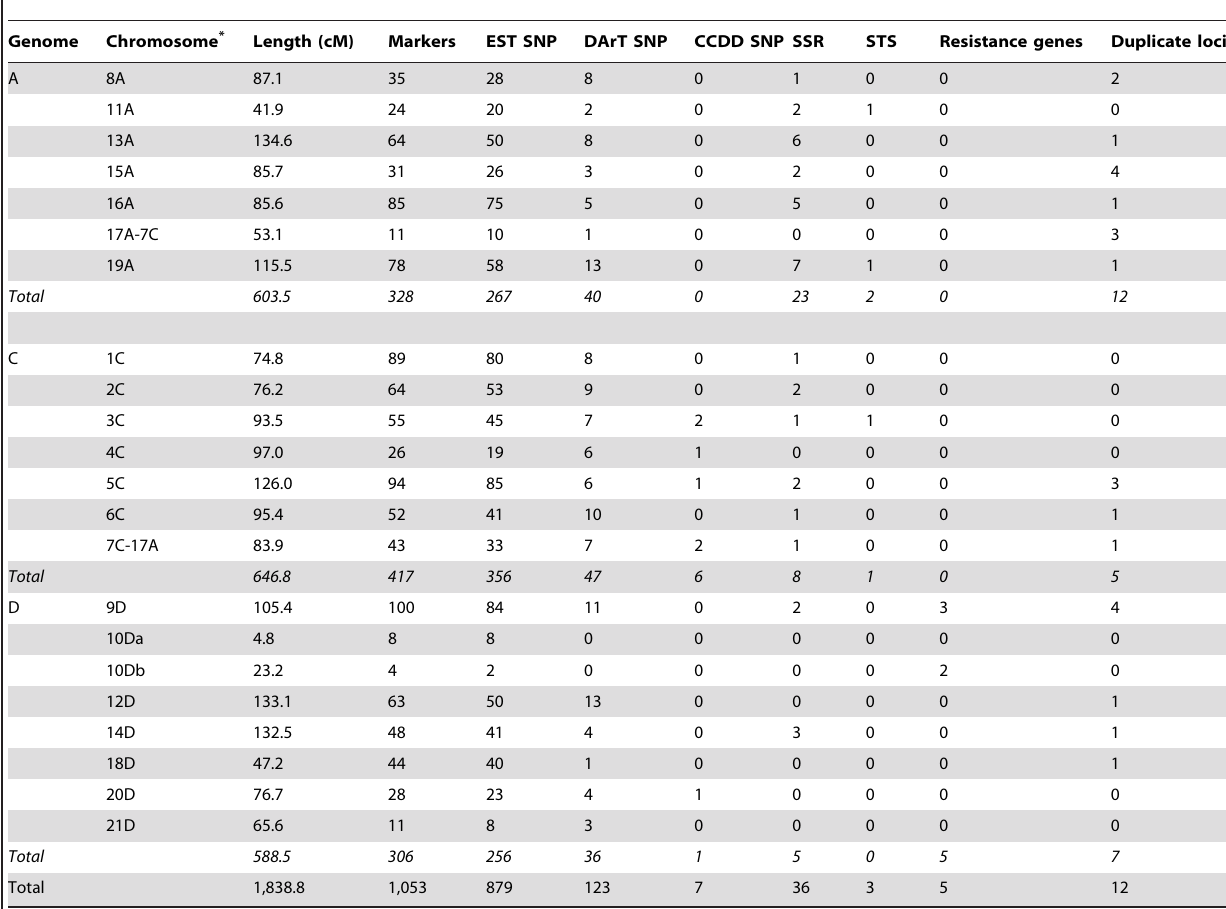
Table 4. Consensus map statistics of chromosome length, marker type, and number of markers per chromosome and genome.